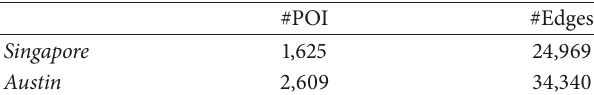
Table 6: Dataset